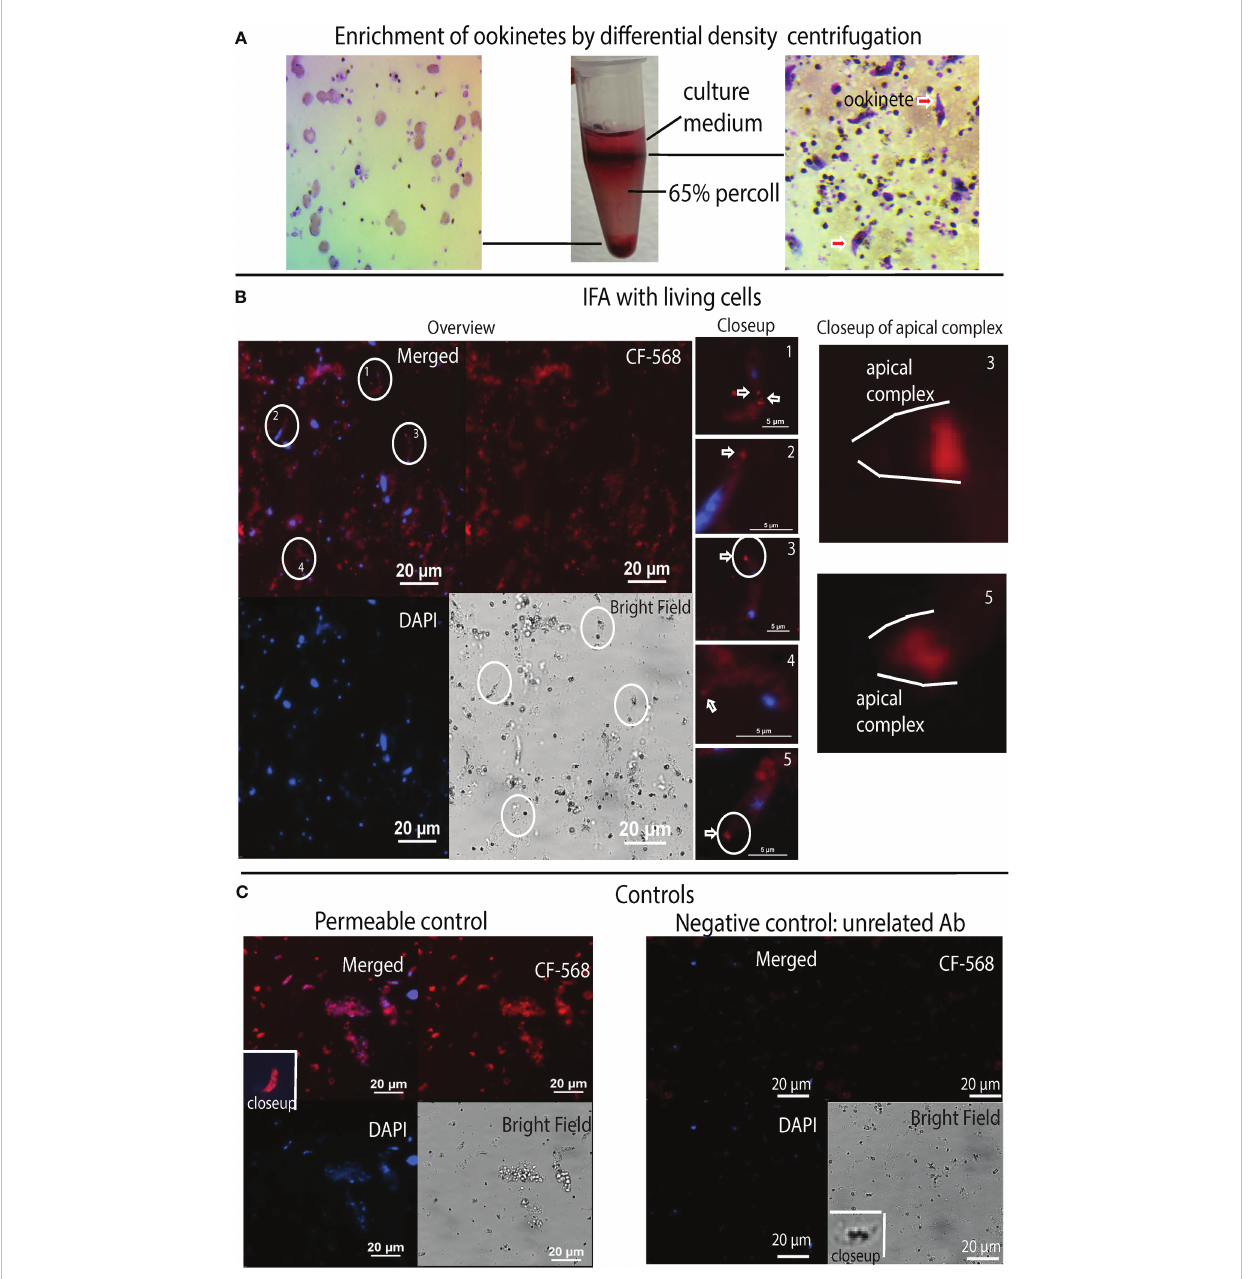
FIGURE 7 Anti- a -tubulin Ab binds live P. falciparum ookinetes at their apical end. (A) Enriching ookinetes through differential density centrifugation using 65% Percoll. Arrows point ookinetes. (B) IFA assays localized a -tubulin-1 on living ookinetes. The co-localization of P. falciparum (nuclei, blue color) and a -tubulin-1 (red). A closeup of individual ookinetes shows Ab bound to the apical end of living P. falciparum ookinetes. A closeup of the apical complex shows anti- a -tubulin Ab bound to the apical polar ring of living ookinetes. (C) Ookinetes stained with CF568 dye-conjugated anti-V5 antibodies as a negative control showed no binding. Ookinetes fi xed by methanol stained with anti- a -tubulin Ab, showing that Ab could stain a - tubulin-1 tubulin inside the permeable